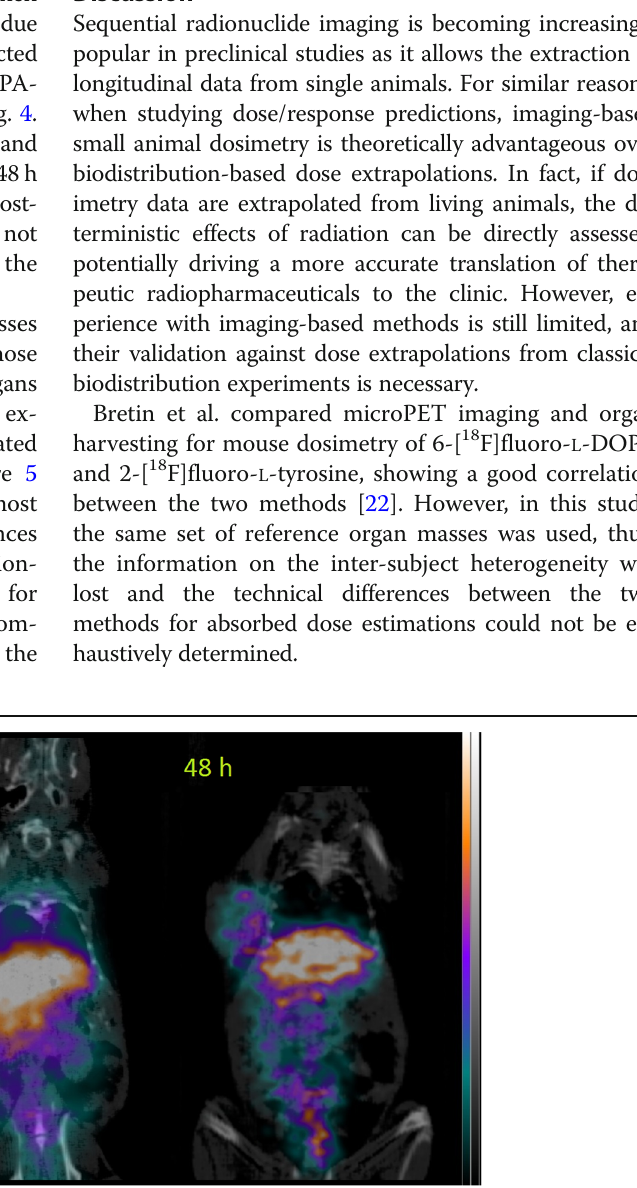
Fig. 3 MicroPET longitudinal imaging of 152 Tb-CHX-DTPA-scFv78-Fc targeting TEM-1 in a mouse bearing a subcutaneous RD-ES